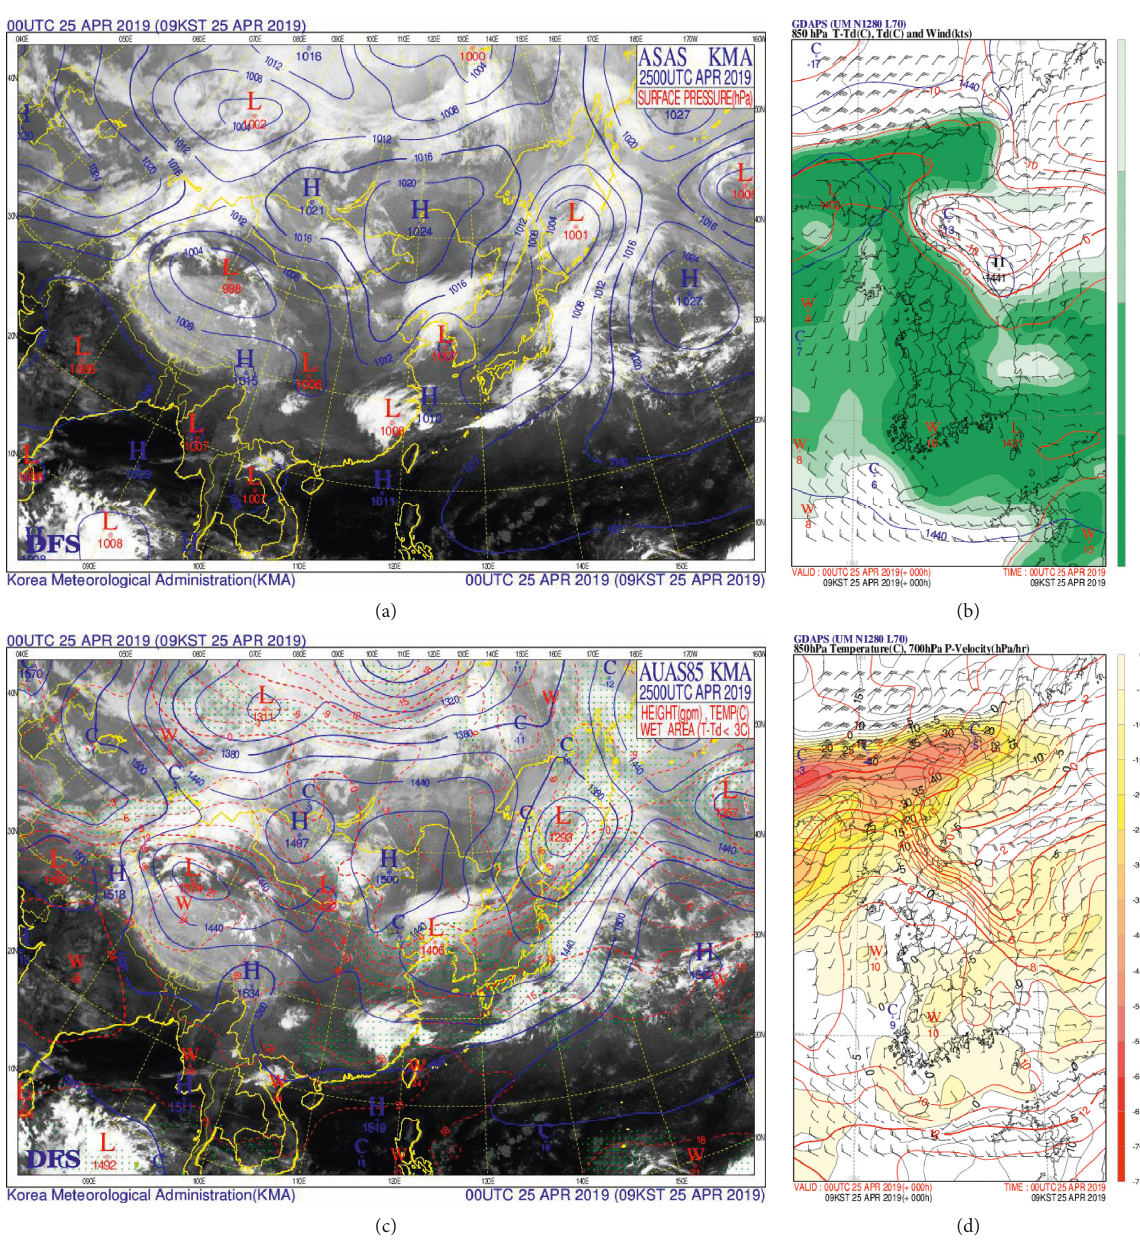
Figure 3: (a) Surface weather chart, (b) gap between temperature and dew point temperature, dew point temperature, wind at 850hPa, (c) weather chart at 850hPa, and (d) temperature at 850hPa and vertical velocity at 700hPa at 0900 LST on April 25, (HD) AWS sites (Figure 8(a)). At the BSWO site (Figure 8), rain was detected but rainfall was not recorded after the cloud seeding experiment at 1023, 1036, 1045, 1050, or 1053 LST. In addition, these three sites recorded approximately 0.5 mm of